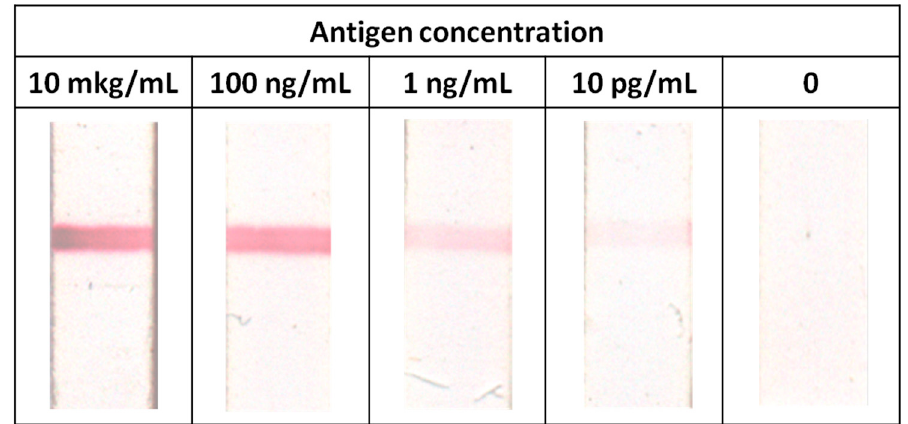
Figure 7. Immunochromatographic testing of the binding of GNP conjugates to Mab and M. tuberculosis antigen MPT64.